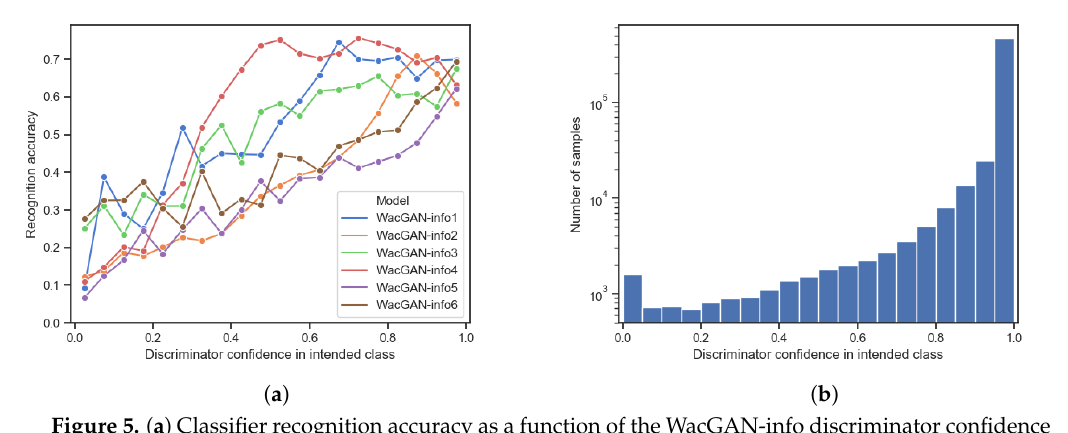
Figure 5. ( a ) Classifier recognition accuracy as a function of the WacGAN-info discriminator confidence in the samples belonging to the intended class, D C . The artificial GAN samples are divided into 20 bins corresponding to the discriminator confidence in each. The bins are uniformly spaced in the interval [ 0;1 ] . From the samples in each bin, the average class recognition accuracy is evaluated using the external classifier. Each color represents one of the six models trained for cross-validation, and the markers represent the bin centers. ( b ) The histogram showing the sample distribution as a function of the WacGAN-info discriminator confidence in the samples belonging to the intended class, D C